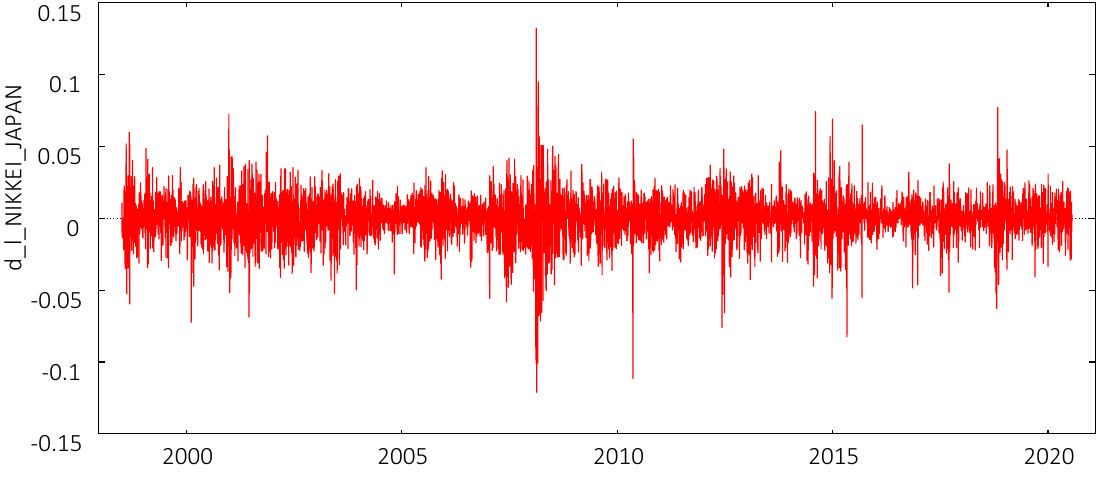
Figure 2. The log-returns of the NIKKEI 225 index using daily closing prices during the sample period